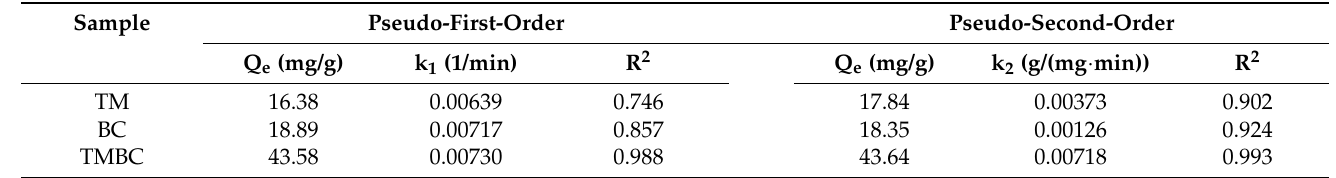
Table 1. Model fitting parameters for adsorption kinetics of Cr (VI) by TM, BC and TMBC.